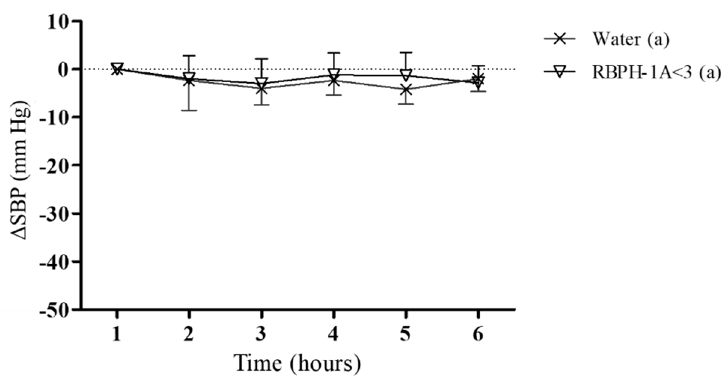
Figure 3. Decrease in the systolic blood pressure caused in Wistar–Kyoto (WKY) rats after the administration of water (x) or 80 mg/kg of the rice bran protein hydrolysate fraction with molecular mass smaller than 3 kDa RBPH-1A<3 ( ) . Data are expressed as mean ± SEM. The experimental groups always had a minimum of eight animals. No statistical differences were observed. The same letters indicate no statistical differences ( p > 0.05). Significance was estimated using two-way ANOVA.